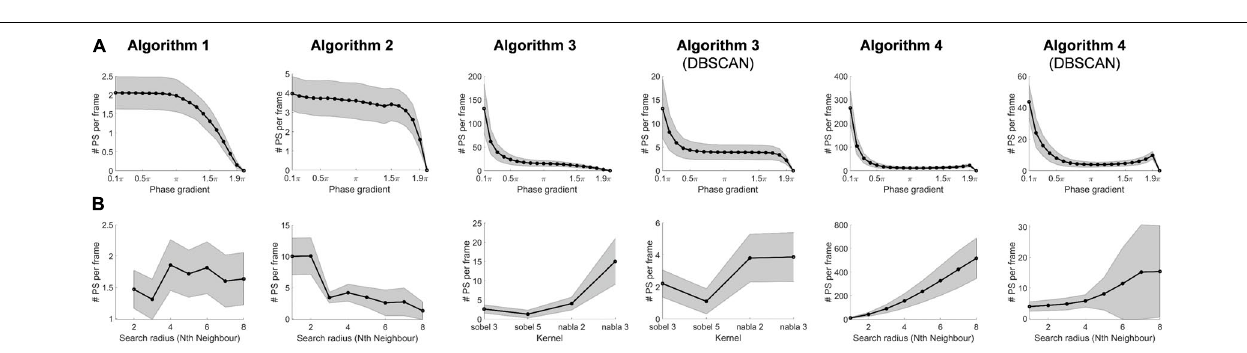
In Figure 8 , the colors on the 3D surface color-coded maps represent the F β scores of the testing data sets of all possible parameters for all algorithms. The setting with maximum F β score was considered as optimal ( Table 1 ). With optimized settings, F β score for algorithm 1 increased from 0.527 to